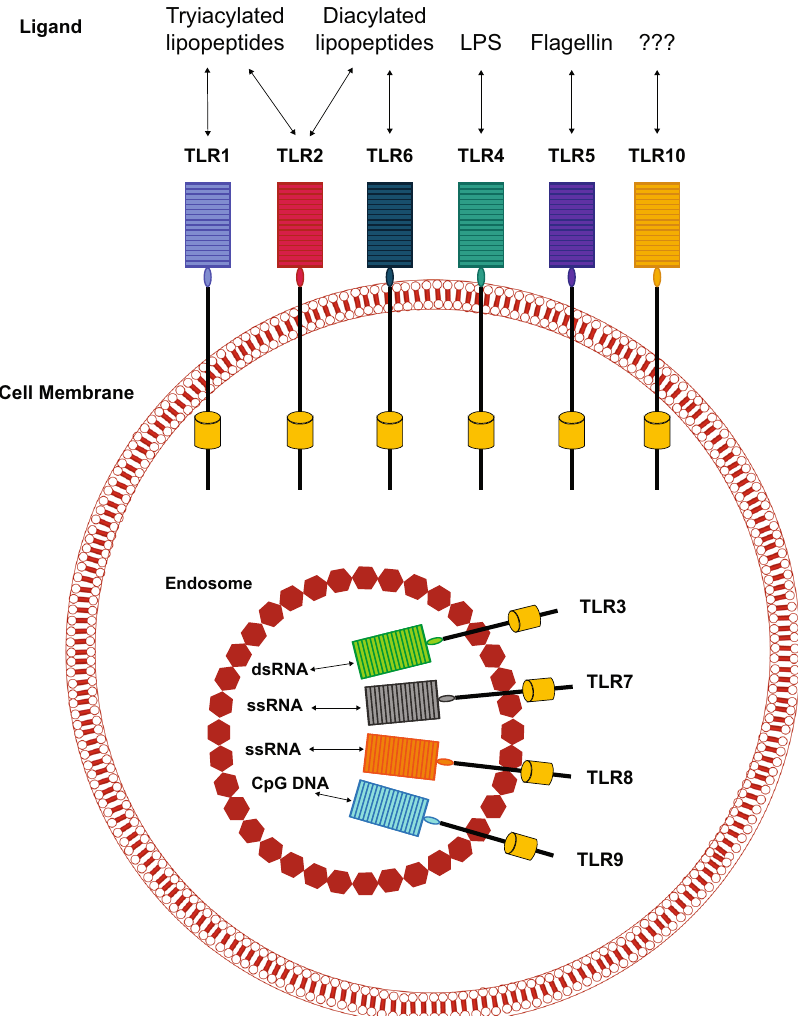
Fig. 1 Cellular localization of the various TLRs and their prototypical ligands. The diagram illustrates the location of the TLRs. Dimerization of TLRs is required to activate downstream signaling but has not been